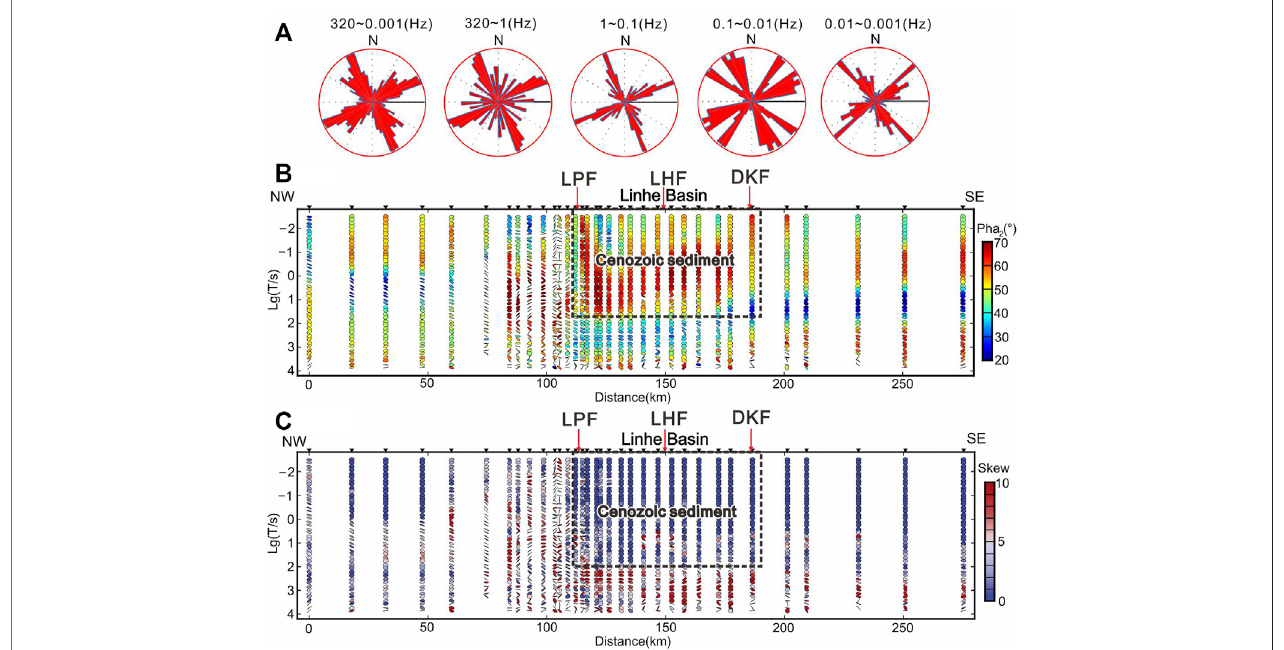
FIGURE 2 | Rose-petal diagram of the electrical orientation (A) , phase tensor invariant, φ 2 (B) , and two-dimensional skewness angle, | β | (C) of different periods of the pro fi le.